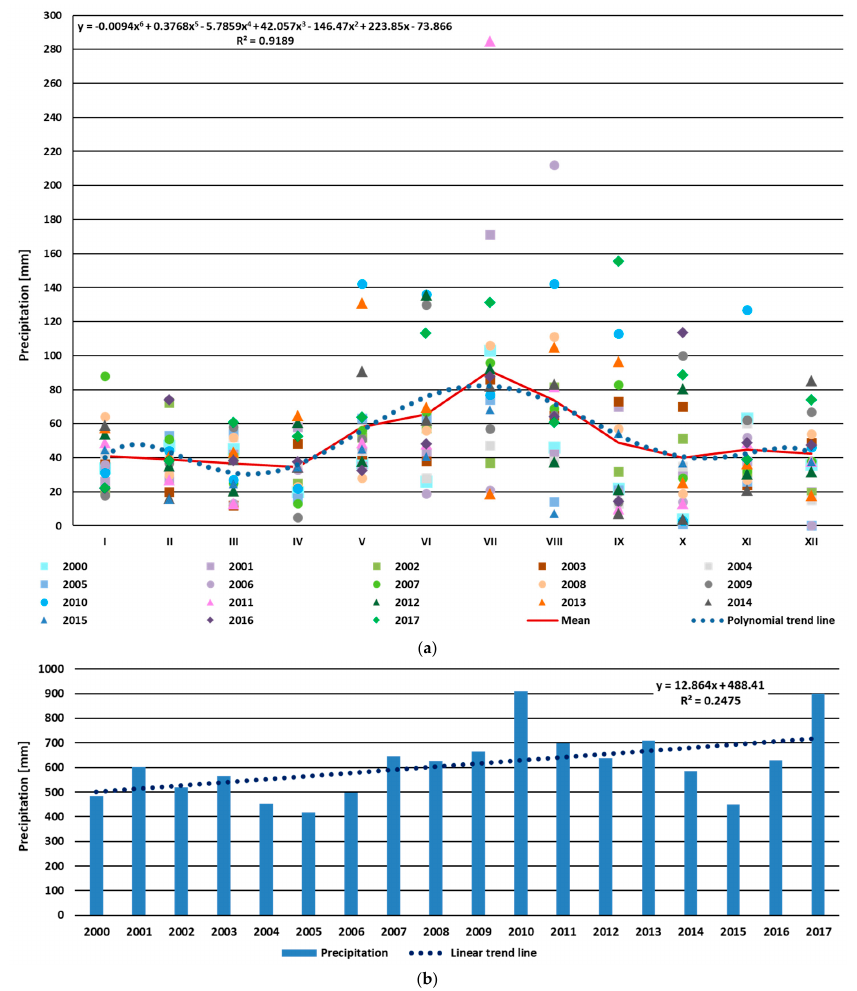
Figure 5. ( a ) The sum of monthly precipitation (adapted with permission from Ref. [45] 2021, MDPI) and ( b ) means for years (mm) in the years 2000–2017, measured in the PAS Botanical Garden CBDC in Powsin, with the trend lines.